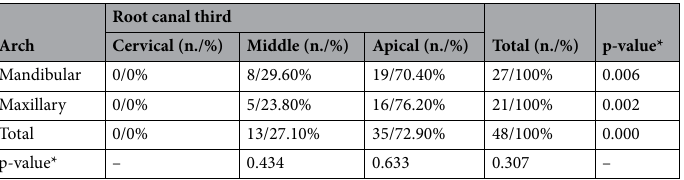
Table 5. Distribution and percentage of fractures considering arch and root canal third. *Value obtained by means of Fisher’s Exact Test (p <